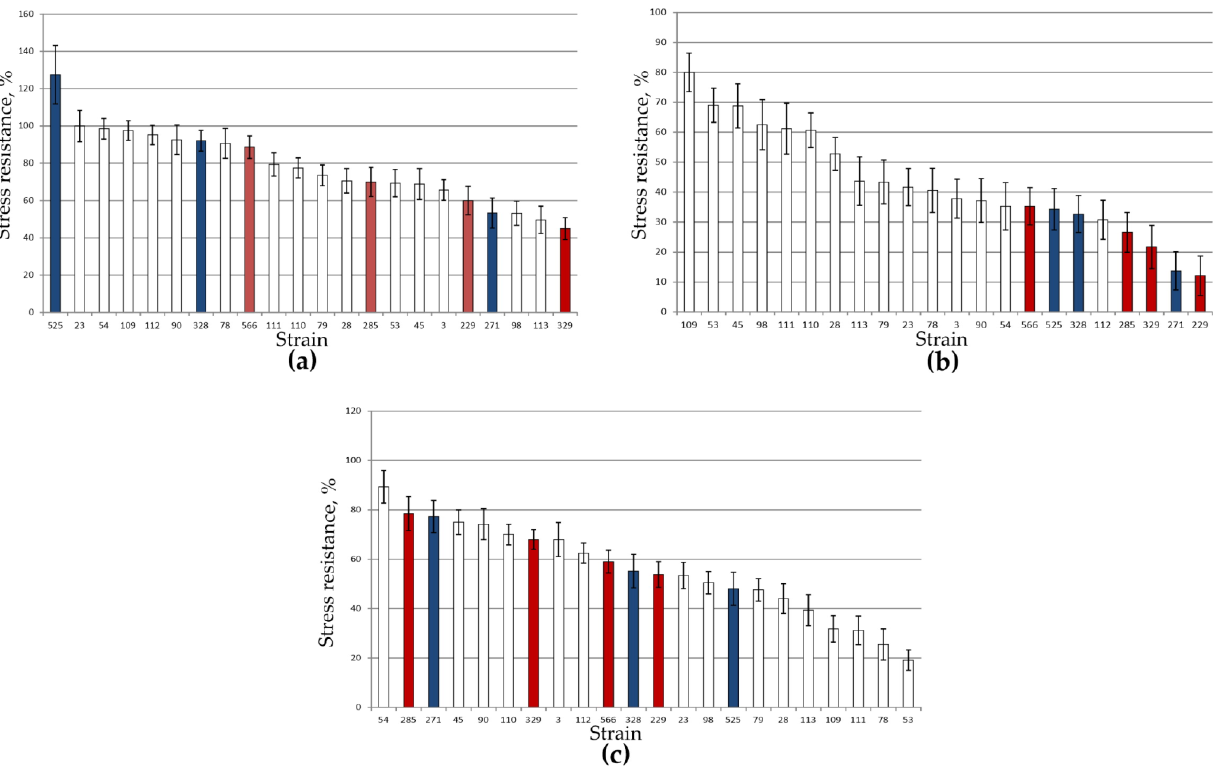
Fermentation 2021 , 7 , x FOR PEER REVIEW Figure 1. Resistance of yeast strains to ( a ) ethanol, ( b ) acetoaldehyde, and ( c ) hydrogen peroxide. Industrial flor strains are shown in red, wine strains in blue, and environmental isolates in open bars. On top bars show standard deviation.